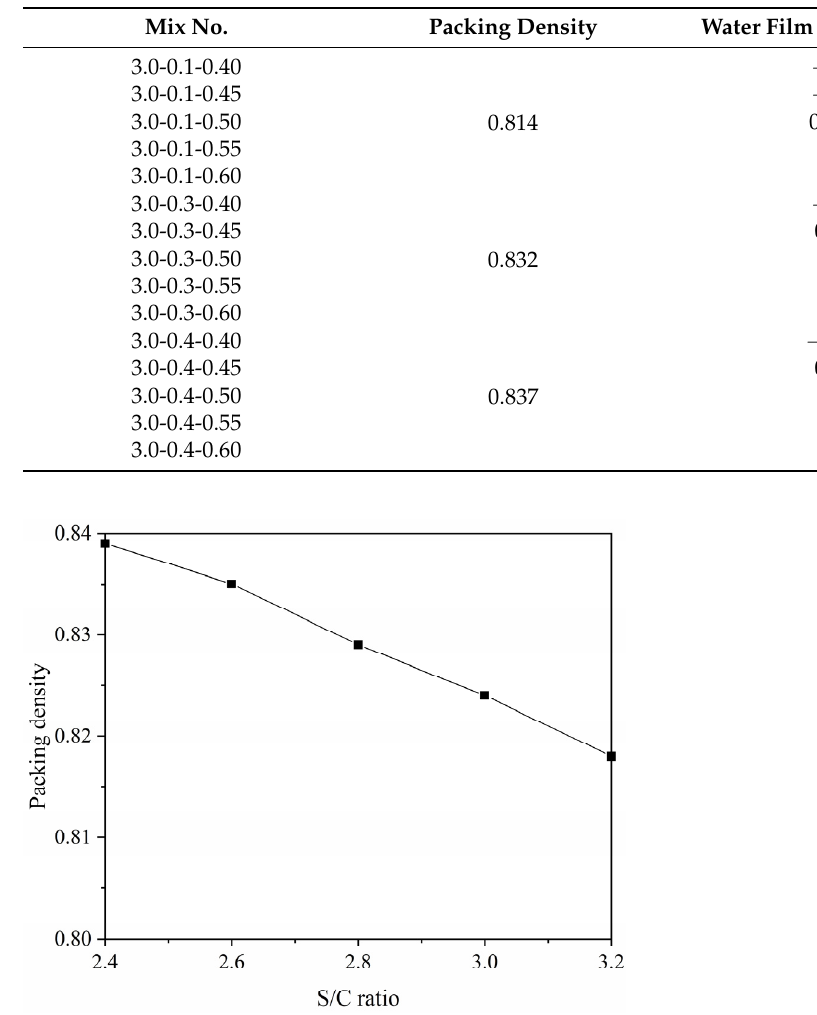
Figure 2. Packing density versus S/C ratio.